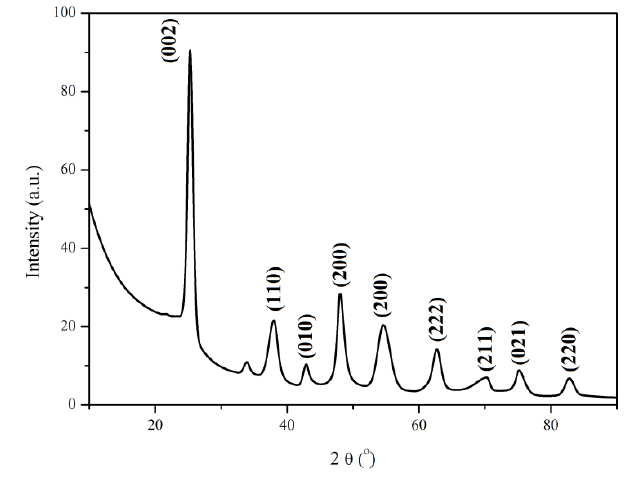
Figure 3. XRD pattern of MWCNTs_TiO 2. Table 2. Summary of the XRD characterisation of synthetised MWCNTs and MWCNTs_TiO 2 .